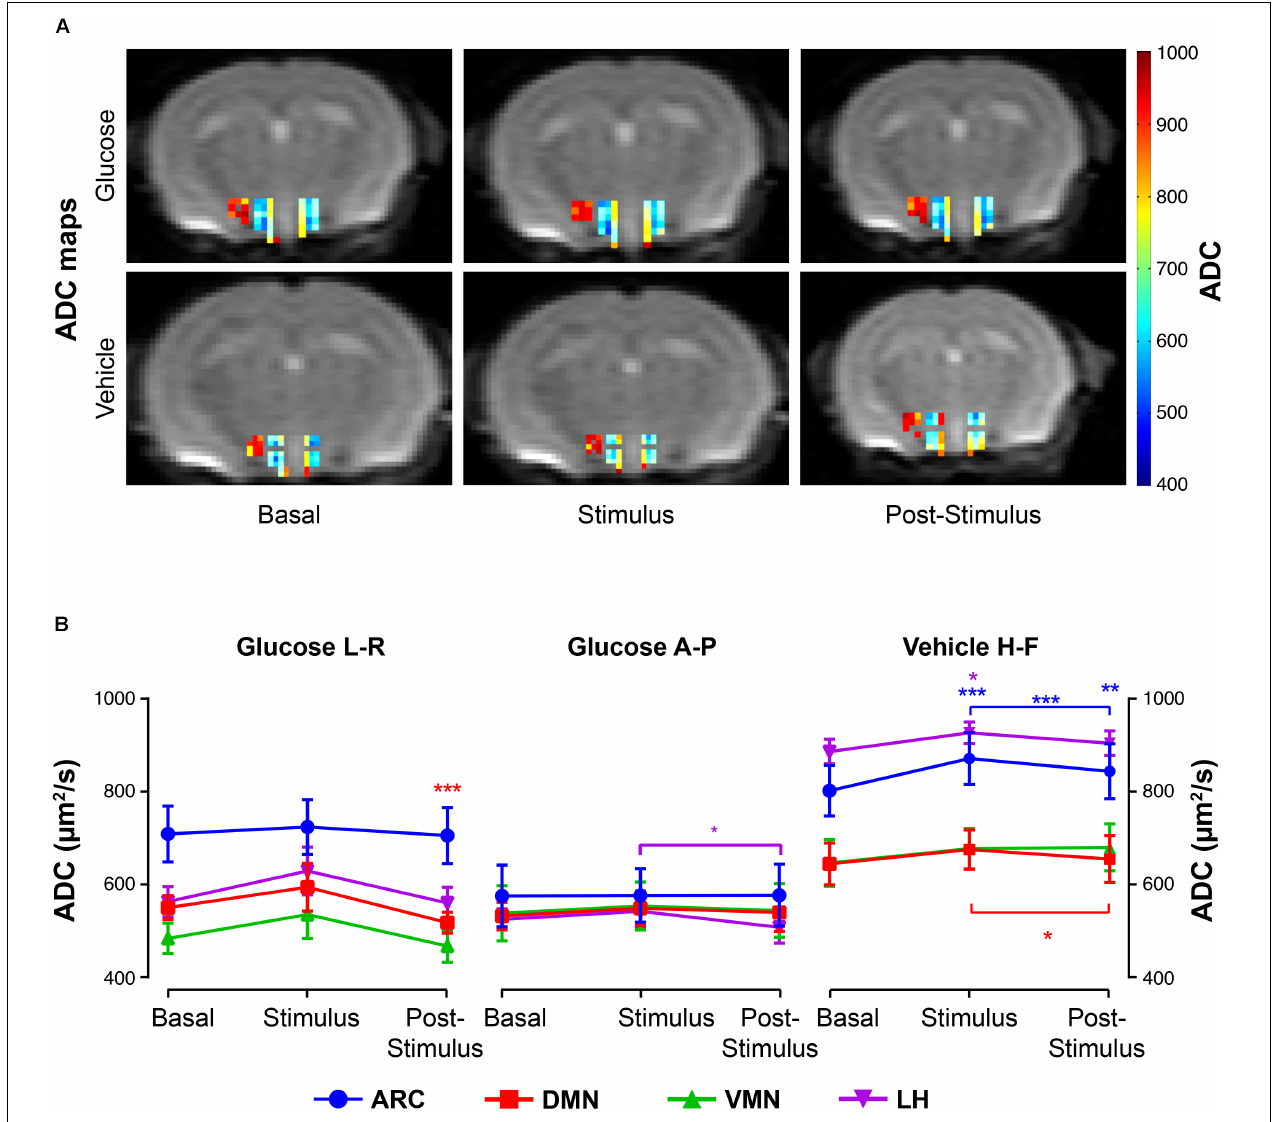
FIGURE 4 | ADC changes in hypothalamic nuclei after the administration of glucose or vehicle to fasting mice. (A) ADC color maps (blue to red scale bar) of representative mice from the glucose (top) or vehicle (bottom) groups before its administration ( basal ), immediately after ( stimulus ), and during the corresponding post-stimulus periods (L-R direction). Colored coded hypothalamic voxels are shown superimposed to the corresponding DWI with b = 0. (B) Mean ADC voxel values ( ± SEM) in the basal , stimulus and post-stimulus periods in the ARC, DMN, VMN and LH nuclei (in blue, red, green and purple, respectively). Only ADC values with statistically significant differences between conditions) are represented ( ∗ p < 0.05, ∗∗ p < 0.005, ∗∗∗ p <